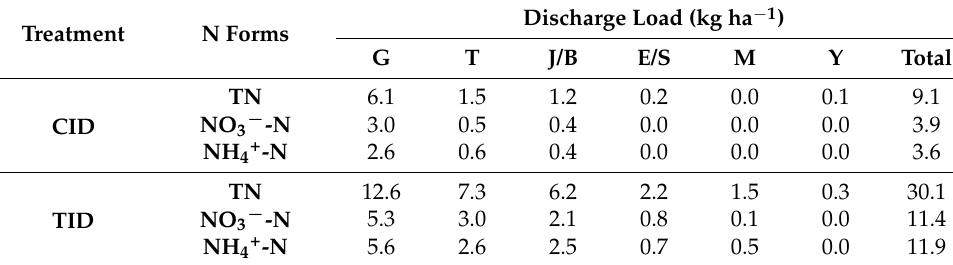
Table 3. Runoff losses of various N forms from the CID and TID modes. Treatment N Forms